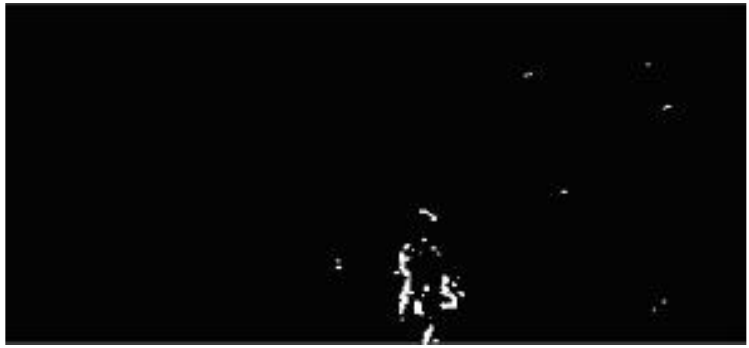
Figure 2. Resultant frame after applying median